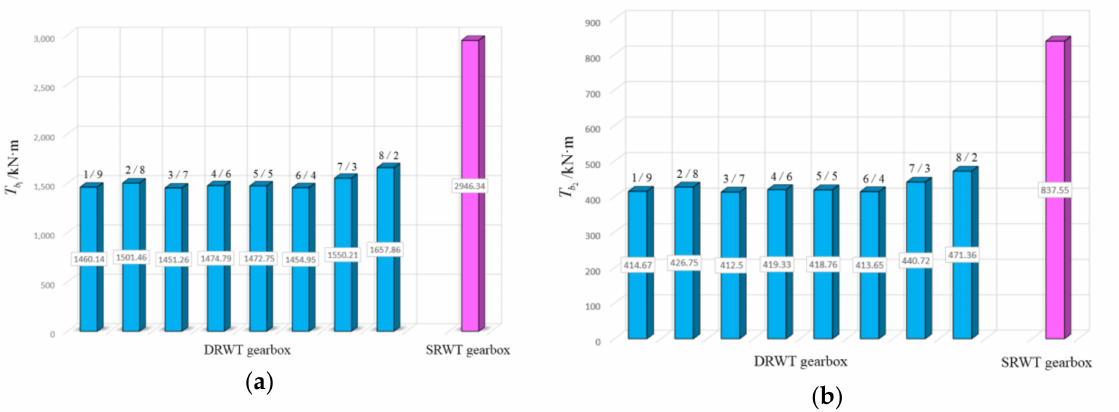
Figure 8. The torque transmitted by ring gear: ( a ) first planetary stage; ( b ) second planetary